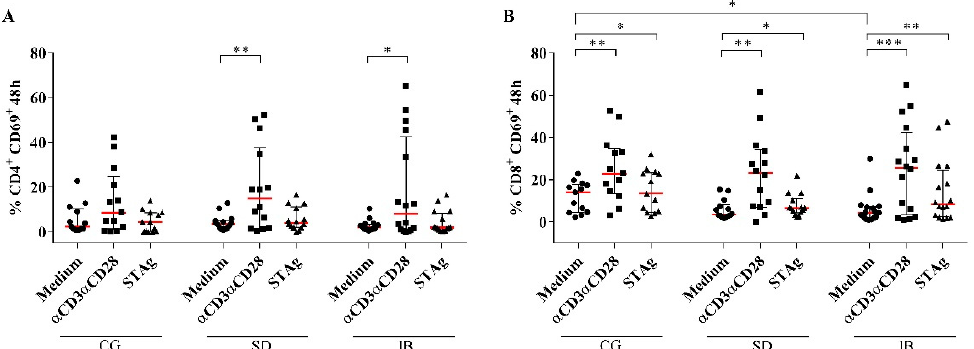
Figure 3. Activation of CD4 + and CD8 + T lymphocytes, assessed by the expression of the CD69 cell surface receptor. ( A ) Percentage of total CD4 + and ( B ) CD8 + CD69 + after 48 h of stimulus with anti- CD3 and anti-CD28, STAg, and absence of stimulus in the CG and SD and IB groups by flow cytometry. Analysis between stimuli by Wilcoxon and among groups by Kruskal–Wallis. The horizontal bars represent the medians with interquartile ranges. Statistically significant data, * p < 0.05, ** p < 0.005, and *** p < 0.0005.